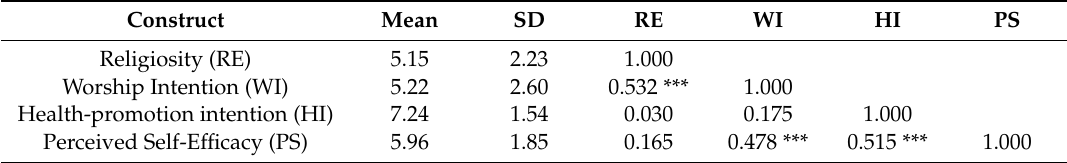
Table 2. Means, standard deviations, and correlations of di ff erent constructs.